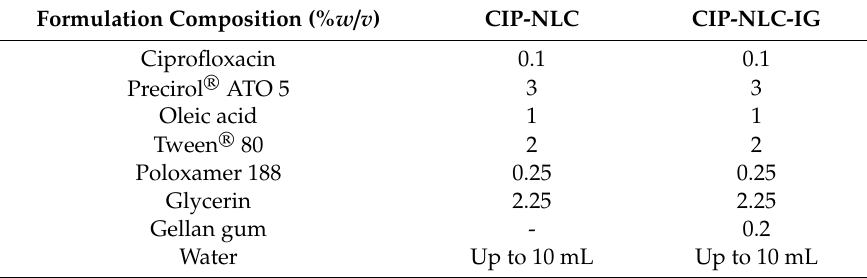
Table 2. Composition of optimized CIP-NLC and CIP-NLC loaded in situ gel system (CIP-NLC-IG) formulations.